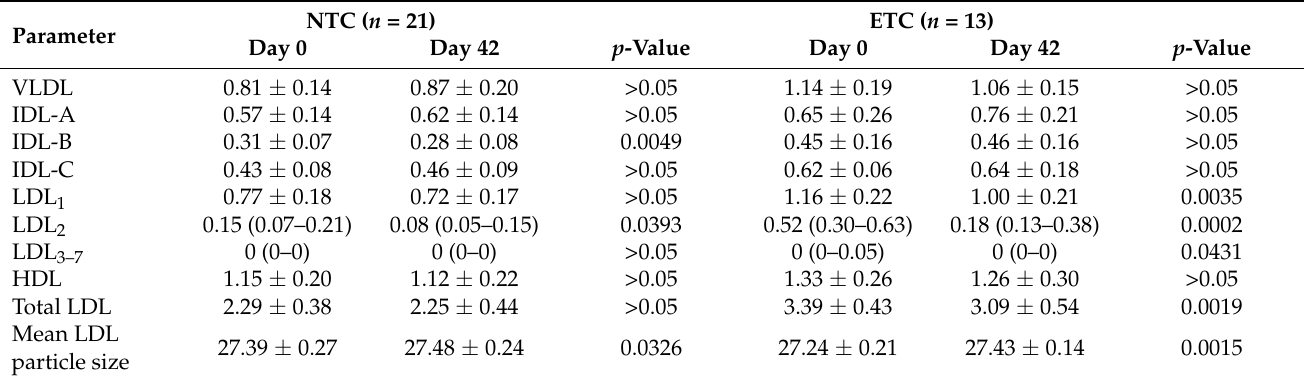
Table 5. Lipoprotein subfractions (mmol/L) and LDL particle size (nm) of the subjects before and after apricot seeds